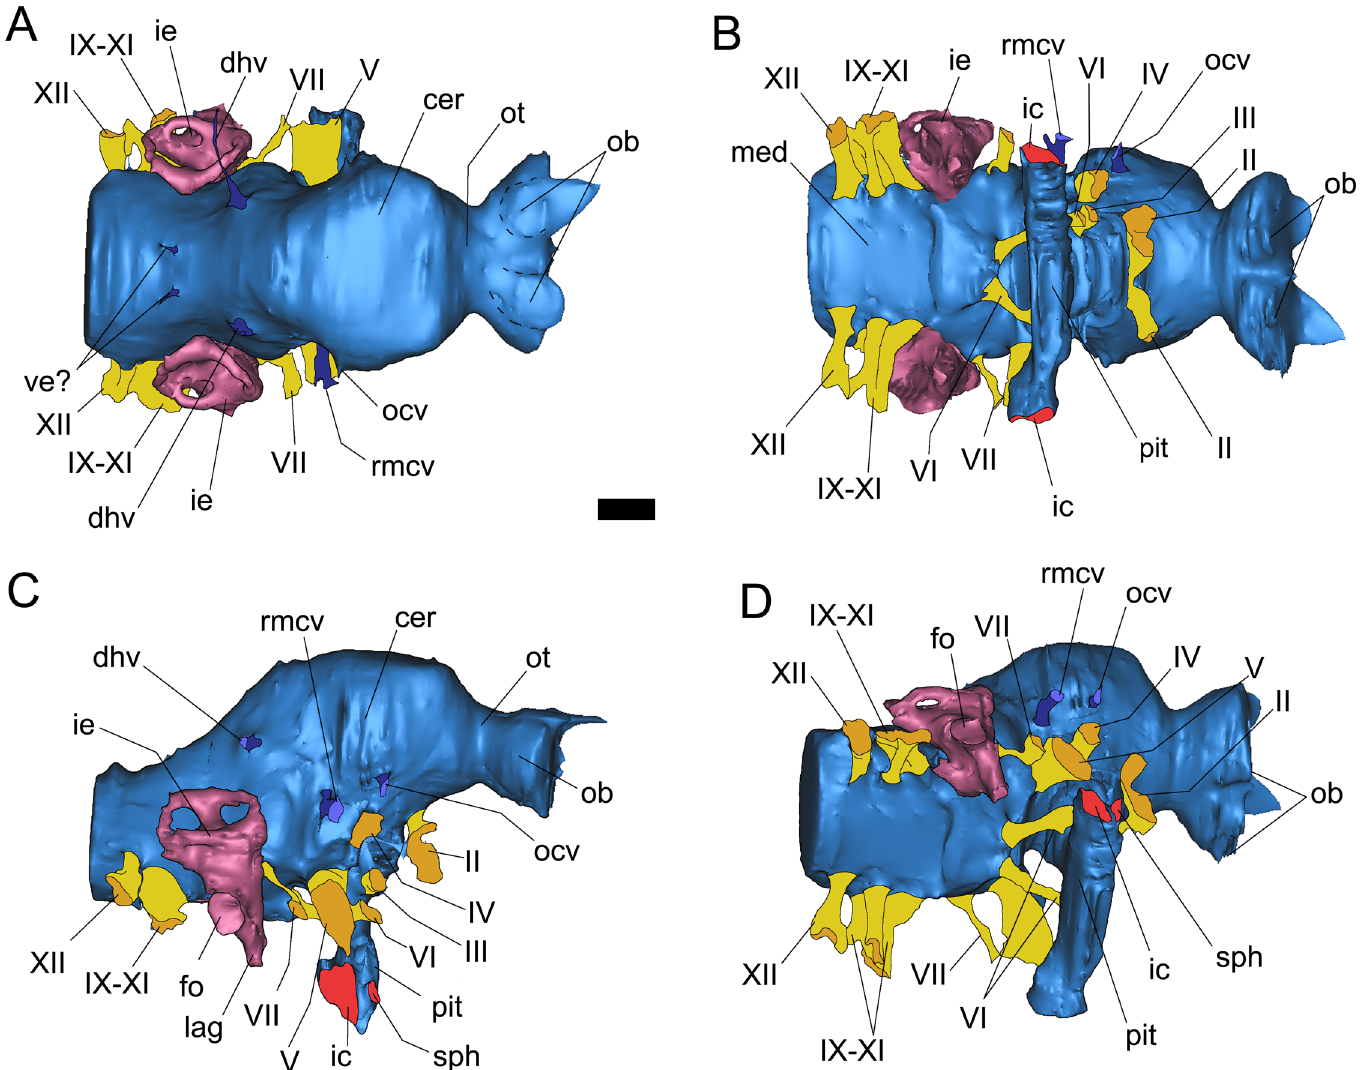
Fig 5. Surface-rendered CT-based reconstructions of the cranial endocast and left endosseous labyrinth of Pawpawsaurus campbelli (FWMSH93B.00026). In the figures, the right inner ear is a mirrored image from the left inner ear. Cranial endocast in dorsal (A), ventral (B), right lateral (C), and lateroventral (D) views. Abbreviations: cer, cerebral hemisphere; dhv, dorsal head vein; fo, fenestra ovalis; ic, internal carotid artery; ie, inner ear; lag, lagena; med, medulla; ob, olfactory bulb; ocv, orbitocerebral vein; ot, olfactory tract; pit, pituitary;; rmcv, rostral middle cerebral vein; sph. sphenoid artery; I – XII, Cranial nerves; ve? vein?. Scale bar equals 10